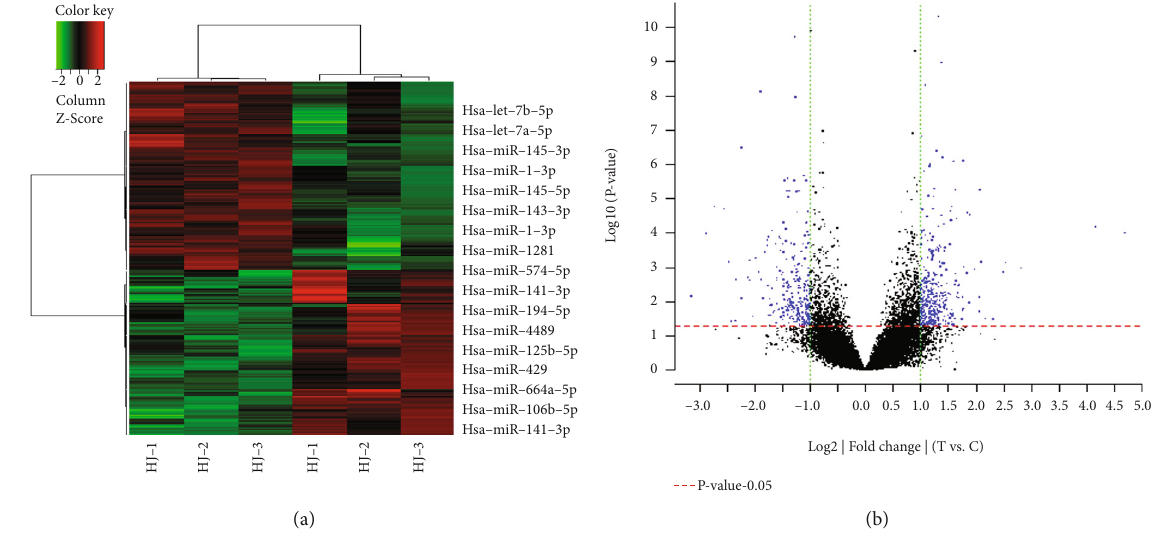
Figure 1: Gene coexpression network analysis. (a) Heatmaps of gene expression. Red is up, green is down. The darker red indicates that the expression is higher, while the darker green indicates that the expression is lower. It can be concluded that the samples can be divided into general clusters: false injury control group and injury experimental group. (b) Blue dots represent genes that have statistically signi fi cant di ff erences in expression. The blue dot represents an increase in gene expression, while the blue dot on the left represents a decrease in gene expression. Black indicates that there is no statistically signi fi cant di ff erence in gene expression. The larger the longitudinal coordinate value, the corresponding point is, the greater the di ff erence in gene expression corresponding to this point. Similarly, the greater the absolute value of the transverse coordinate corresponding to the point is, the greater the di ff erence in gene expression corresponding to the